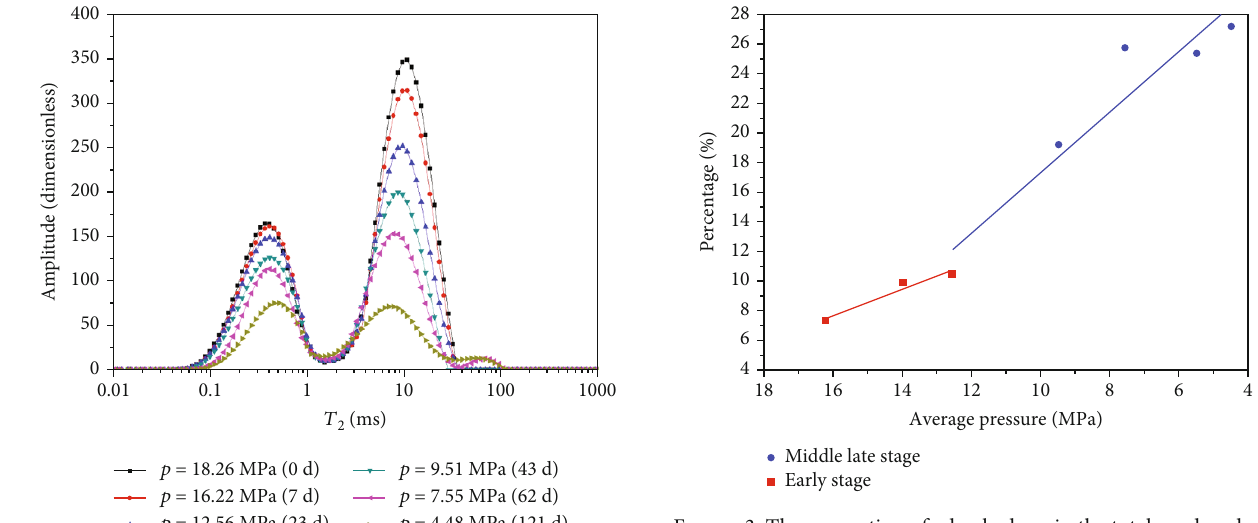
Figure 3: The proportion of adsorbed gas in the total produced gas at di ff erent average pore pressures. ff erent Figure 2: The T 2 spectrum distribution at di